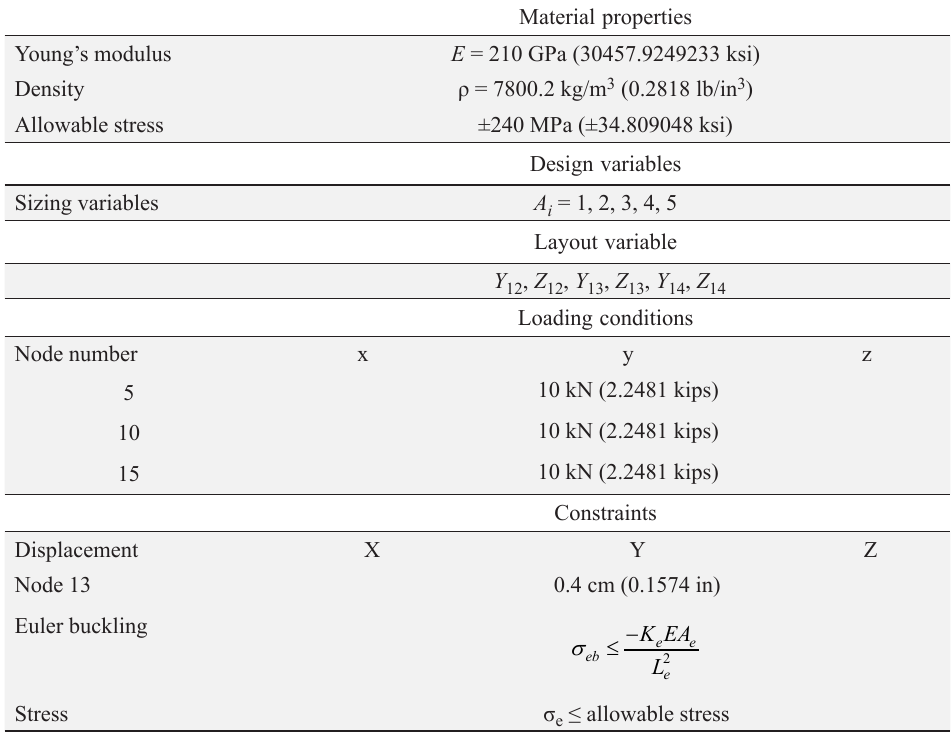
Table 8. Input data for the spatial 39-bar truss problem